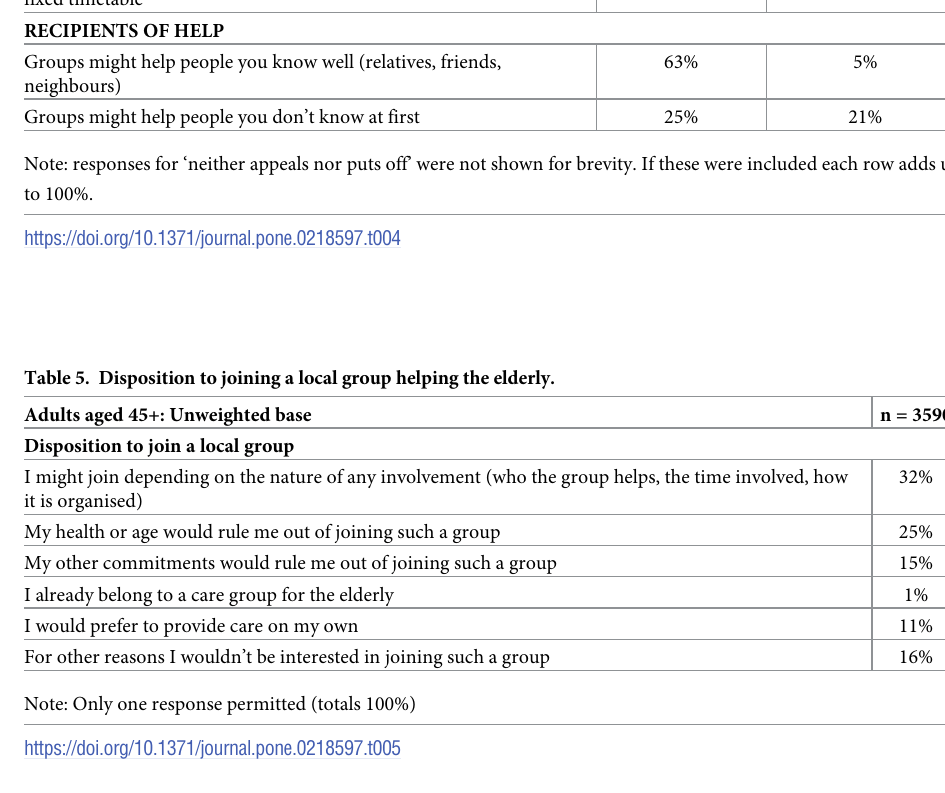
Total for whom it Total for whom it is appeals